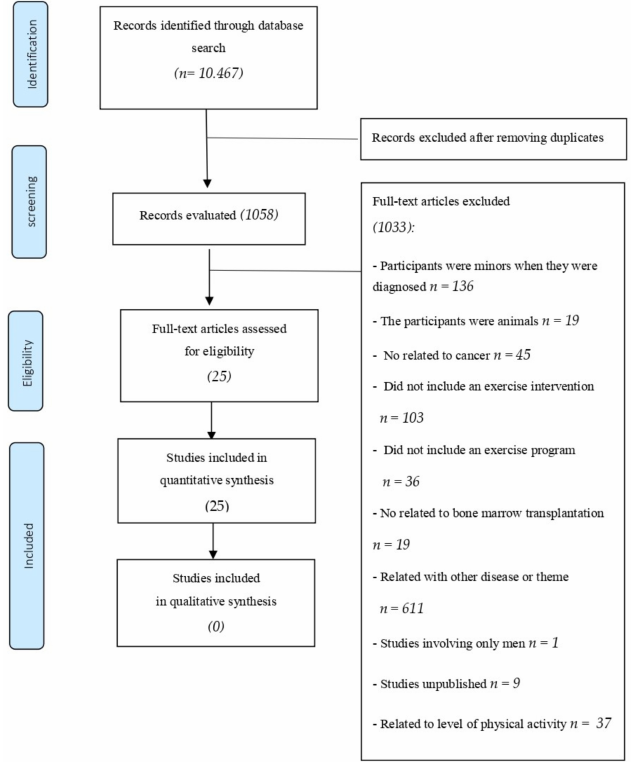
Figure 1. Systematic review flow